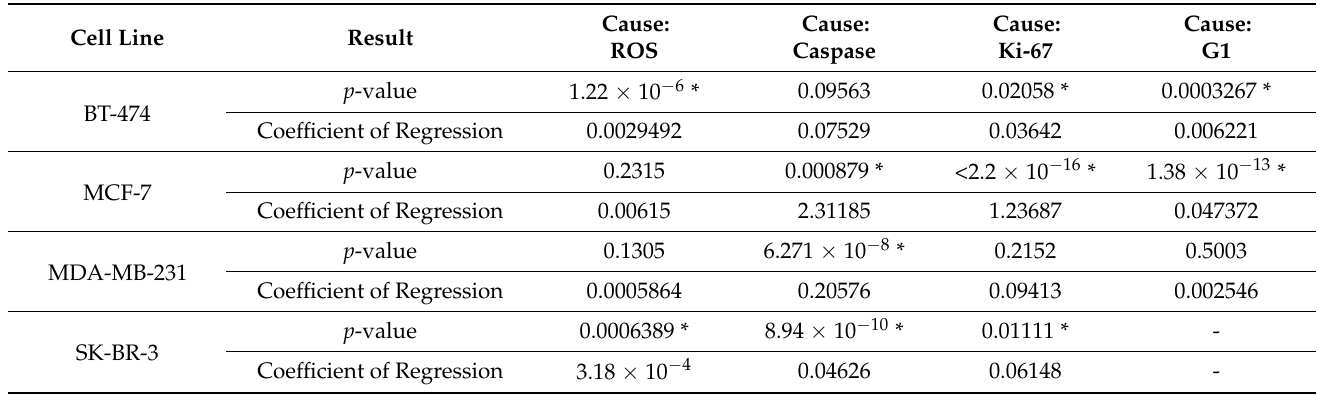
Table 2. p -values and coefficients of linear regression for all cell proliferation models for cells treated for 3 min (* p < 0.05).